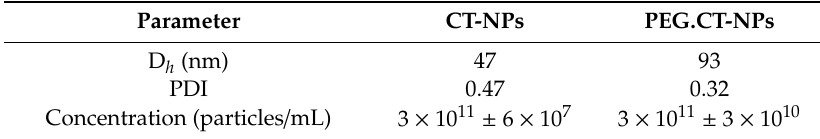
Table 1. Hydrodynamic diameter (D h ), polydispersity index (PDI) and concentration of chitosan nanoparticles (CT-NPs) and PEG.CT-NPs, as measured by dynamic light scattering (DLS) and nanoparticle-tracking analysis